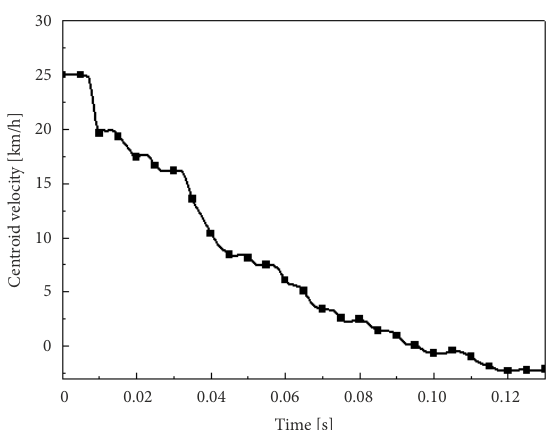
Figure 3. Speed change of gravity center of the vehicle